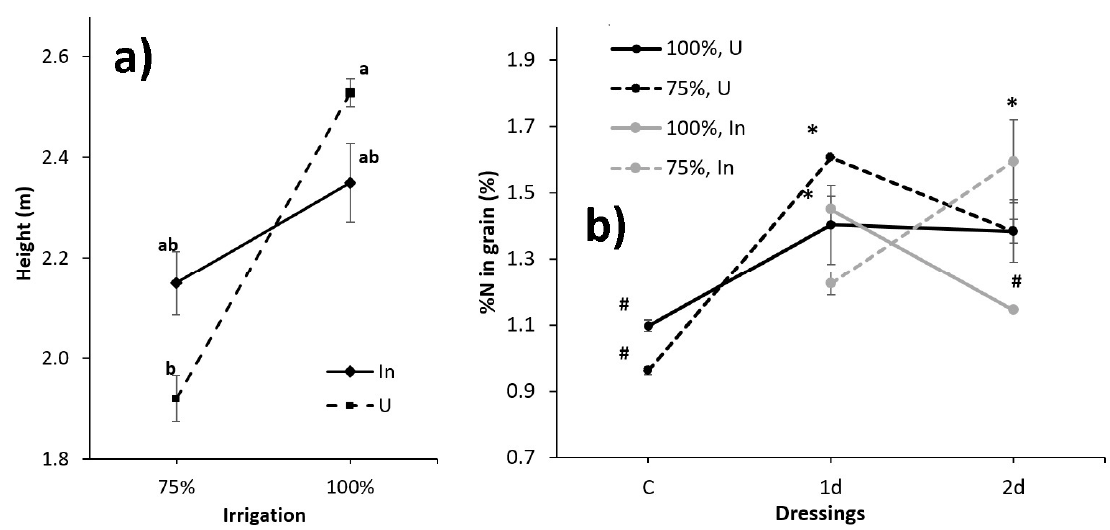
Figure 3. ( a ) Combined effects of urease inhibitor use and irrigation intensity in plant height and ( b ) combined effects of inhibitor use, irrigation intensity (100% or 75%), and number of dressings in %N in grain. In the %N in grain plot. Significant differences among treatments are indicated by the letters a, ab and b. * indicates significant differences ( p < 0.05) with the sub-optimally irrigated control (C75%) treatment. # indicates significant differences ( p < 0.05) with the In 2d , 75% treatment.